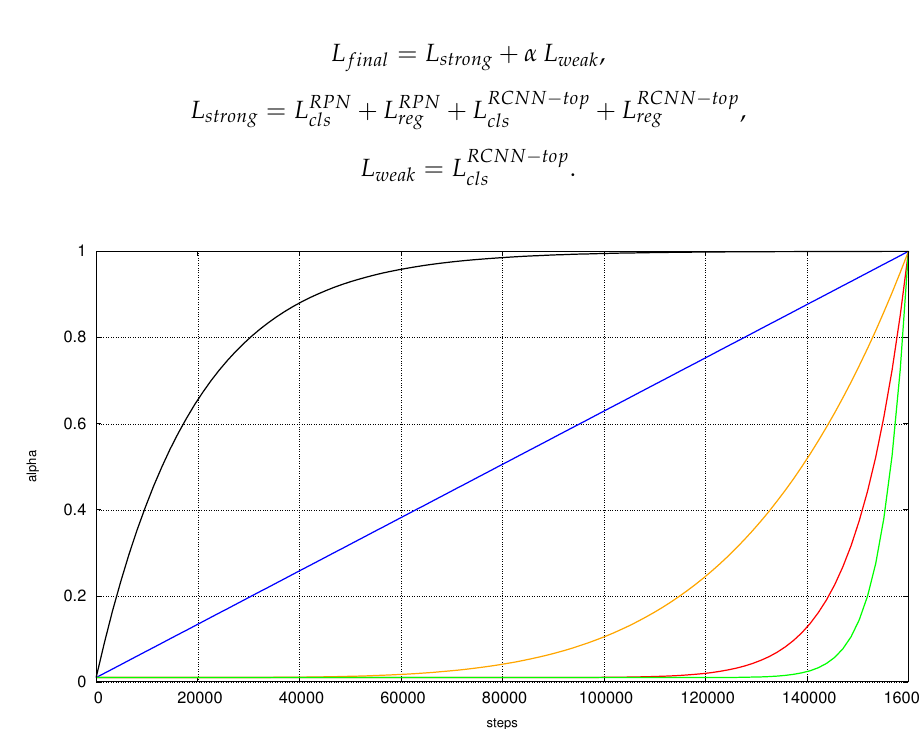
Figure 2. Illustration for the tendancy of alpha when the step size is 160000. The black plot shows a log-like increase, namely inverse exponential, in α , which converges to 1 quickly. The blue plot is a linear increase of α . (1), (2), (3) are the conservative increase of α during the training phase, namely polynomial increase, which relates to the orange plot, red plot, and green plot,